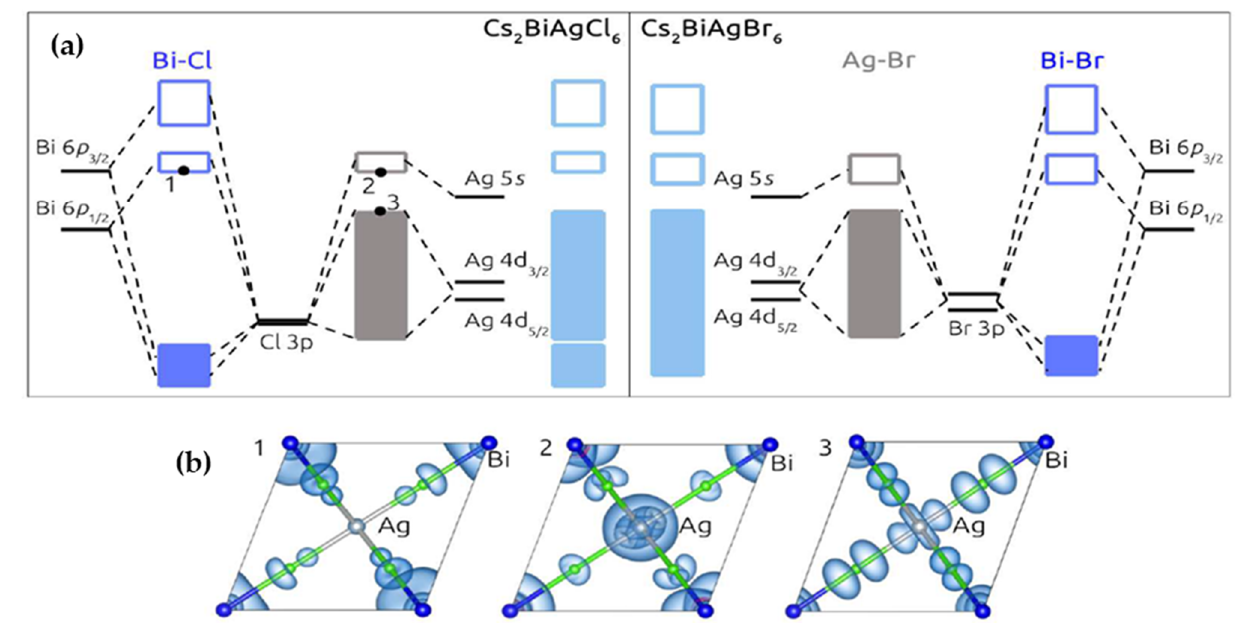
Figure 3. ( a ) Comparison between the molecular orbitals diagram of Cs 2 AgBrCl 6 and Cs 2 AgBrBr 6 and; ( b ) Square modulus of the wave functions for states marked from 1 to 3 on the molecular orbital diagram of Cs 2 BiAgCl 6 . 1 represents the Bi-6p 1/2 /halide-p antibonding orbitals at the bottom of the conduction band (at Γ point). 2 is the antibonding Ag-5s/halide-p at the L-point of the conduction band), while 3 corresponds to the Ag-4d/halide-p antibonding orbitals found at the top of the valence band (at X-point). Reproduced with permission from [57]. Copyright 2016, American Chemical Society.